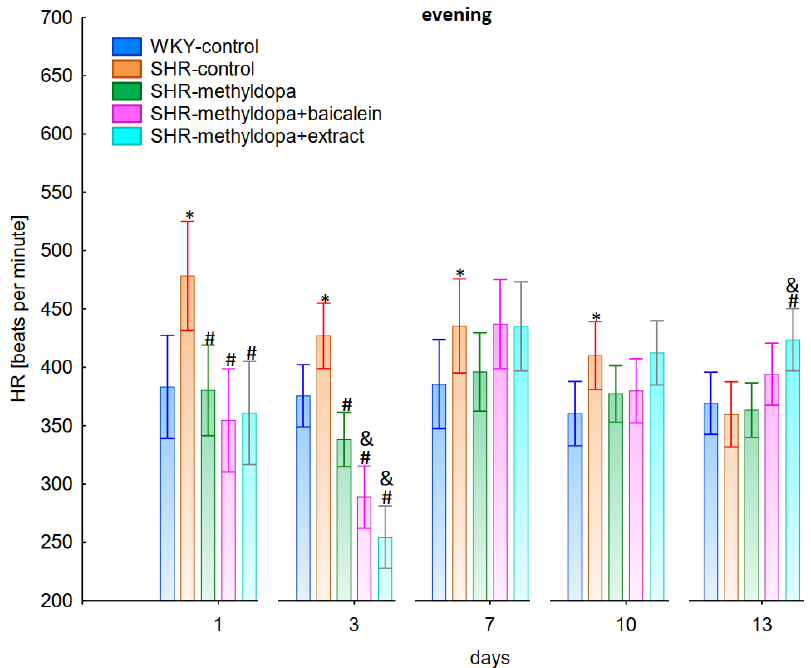
Figure 9. Influence of methyldopa and its combination with baicalein or extract from Scutellaria baicalensis roots on evening heart rate (HR) in SHR pregnant rats. Legend: n = 10, mean ± SEM; *—vs. WKY control, p < 0.05; # — vs. SHR control, p < 0.05; & — vs. SHR-methyldopa, p < 0.05. Administration of methyldopa significantly ( p < 0.05) reduced SBP in SHR animals at all time points, with the strongest decrease on day 3, whereas the drug significantly ( p < 0.05) reduced DBP and HR in SHR animals on days 1 and 3 only, while at the remaining time points the obtained values did not differ significantly from the SHR control group. Baicalein and S. baicalensis root extract administered together with methyldopa signifi- cantly ( p < 0.05) decreased SBP in relation to animals receiving methyldopa alone on days 1, 3, and 7 (on this day baicalein only), whereas the flavonoid and S. baicalensis root extract when administered together with methyldopa significantly ( p < 0.05) decreased DBP and HR in relation to animals receiving methyldopa alone on day 3 only (the extract also on day 1). Surprisingly, on day 13 the extract was associated with an elevation of HR when compared both with SHR control and methyldopa groups. 2.2.4. Comparative Analysis of the Influence of Time of Day and Duration of the Experiment In the next stage of the analysis, changes in SBP, DBP, and HR were compared be- tween administered methyldopa and its combination with baicalein and S. baicalensis root extract with regard to the time of day of administration. Figures 10 – 12 show the mean SBP, DBP, and HR over a period of 13 days of the experiment, respectively. The main effects (group effects) were found to be statistically significant (for SBP: ANOVA II: F(4, 48) = 15.4, p < 0.0001; for DBP: ANOVA II: F(4, 60) = 11.1, p < 0.0001; and for HR: ANOVA II: F(4, 60) = 11.1, p < 0.0001).